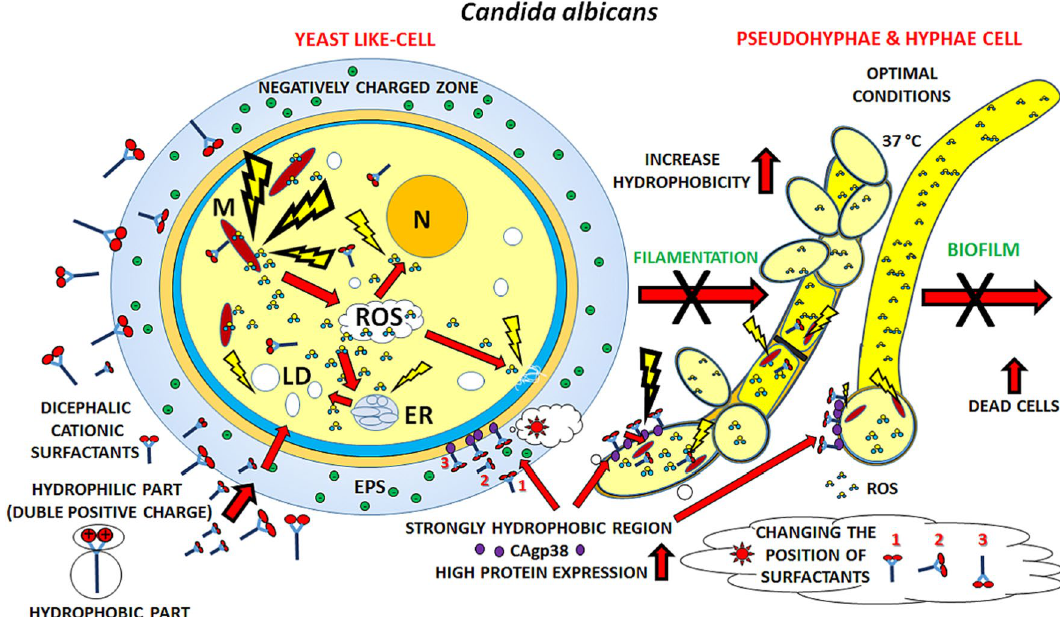
Figure 7. Molecular mechanism of action of dicephalic cationic surfactants on C. albicans cells, which takes into consideration domain structure of yeast cells, morphological changes (filamentation) of yeast-like cells to pseudohyphal and hyphal cells as well as ionic and hydrophobic interactions. Yeast cell at the first stage of adhesion starts to synthesize increased amounts of EPS (including exopolysaccharides), which determine the increase in negative surface charge of the cell, together with other cell structures. It results in the ability of double-headed cationic surfactants with their double positive charges to bind to negatively charged cell structures, orienting their hydrophilic heads towards the cell surface. Then the surfactants could interact with other areas of the yeast cell, including more hydrophobic ones, due to increased expression of proteins, which allows the surfactants to penetrate into the cell, change orientation and interact with hydrophobic molecules and cell membranes with their n-variable alkyl chains. Penetration of surfactants into the cell may cause